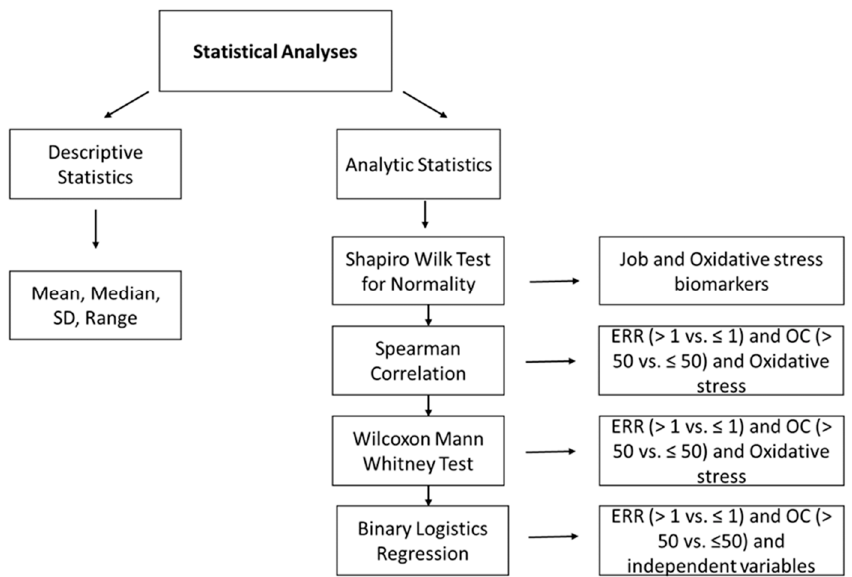
Figure 3. Flow diagram showing rationale for various statistical methods used for data analysis. Two types of statistical analyses were performed: Descriptive statistics for computing percentage (%), mean, standard deviation (SD), median, range of variables; and analytical statistics: Shapiro–Wilk test was performed to determine normality, Wilcoxon–Mann–Whitney test was used to analyze non- parametric data, and binary logistic regression analysis was performed to measure association between job stress indicators, and independent .variables ERR: Effort Reward Ratio; OC: Overcommitment.